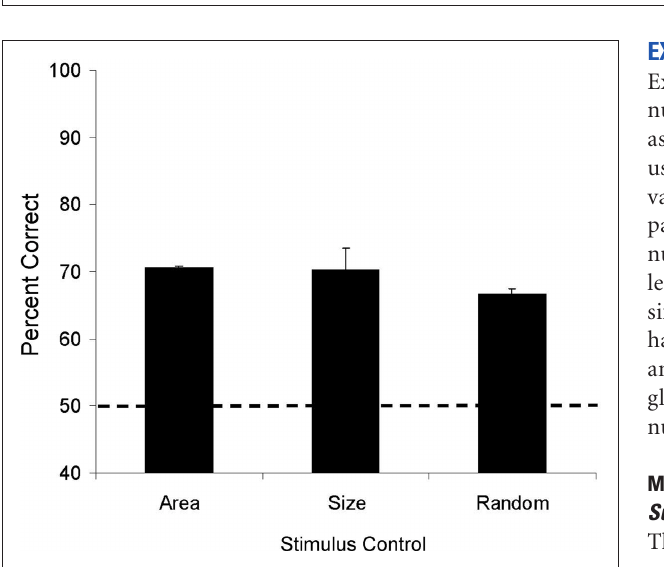
Figure 2 | Average first session accuracy during training in blocks of four stimulus sets and performance during the 10 transfer sessions. The dotted line indicates chance for the task.